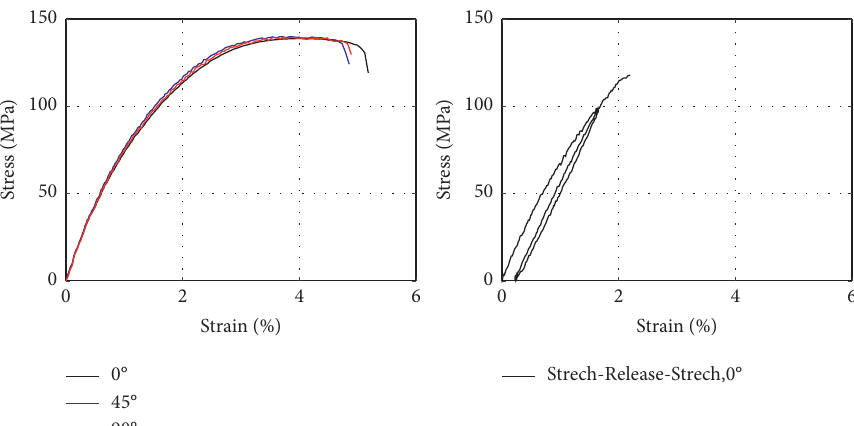
Figure 10: The engineering stress-strain curve of oil sump material (left: stretch curve; right: stretch-release-stretch curve and strain rate).